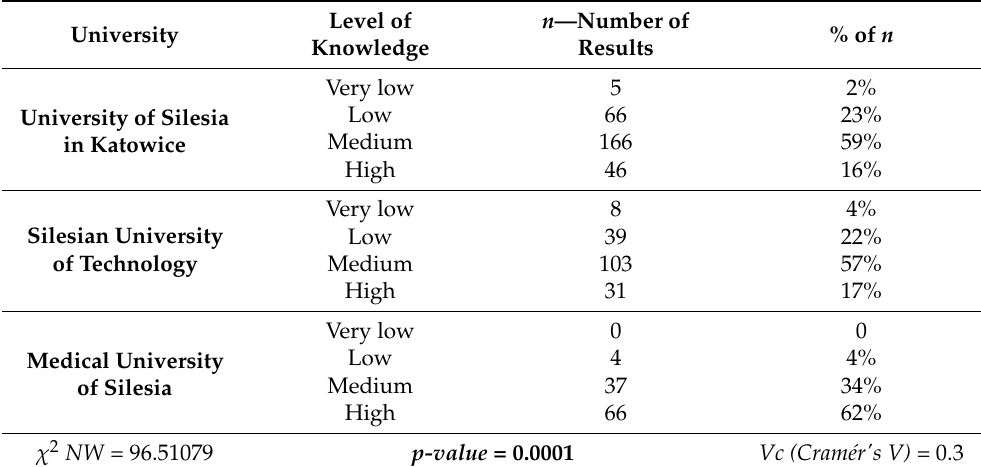
Table 4. Students’ level of knowledge of gut microbiota and CRC depends on the university they attend. Source: own